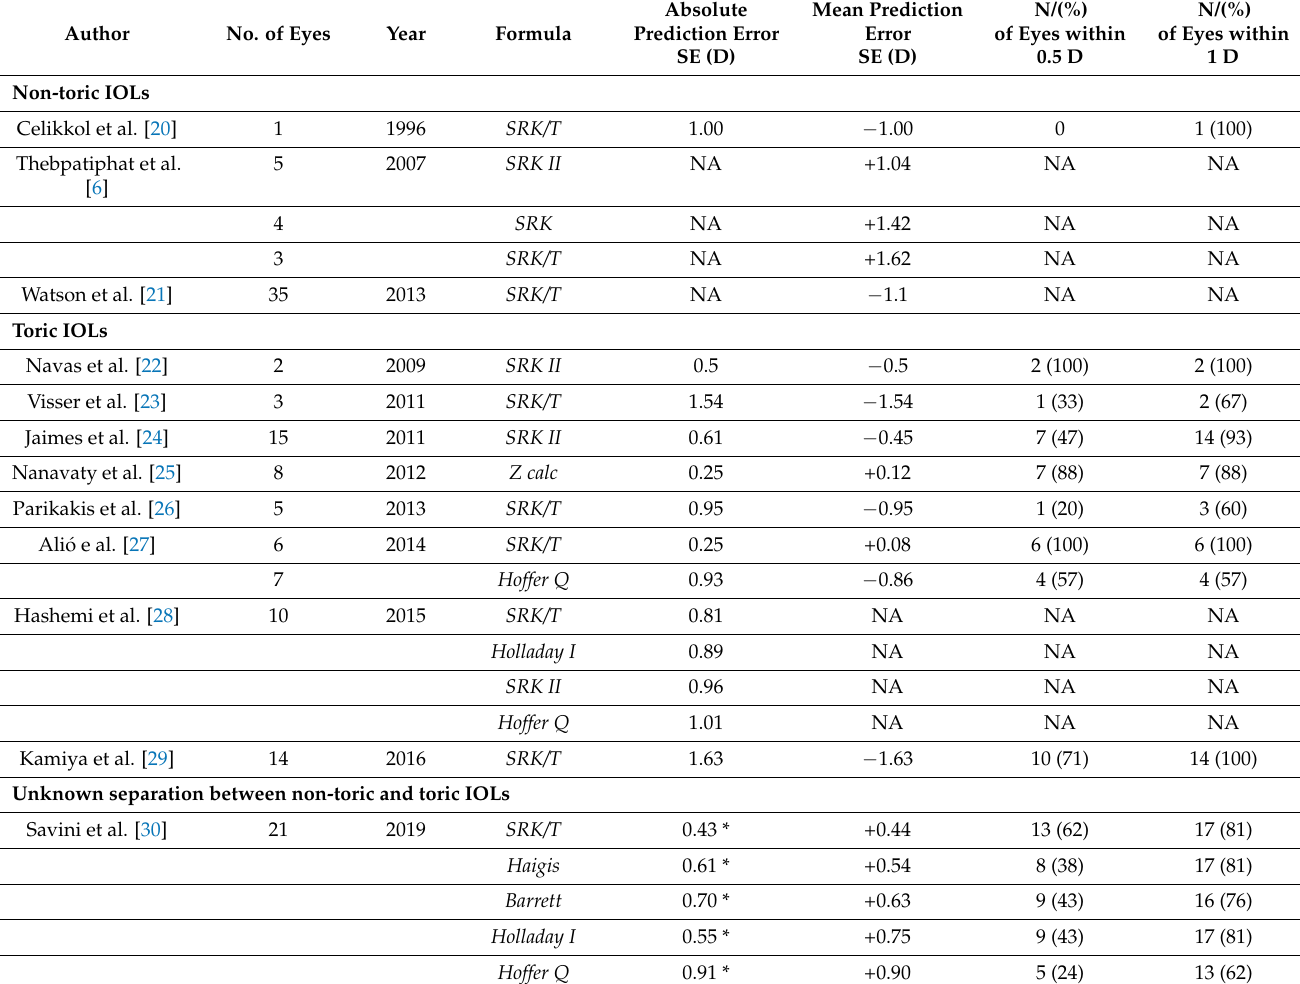
Table 2. Mean error in non-toric and toric IOL power calculation in keratoconus stage I eyes based on Krumeich